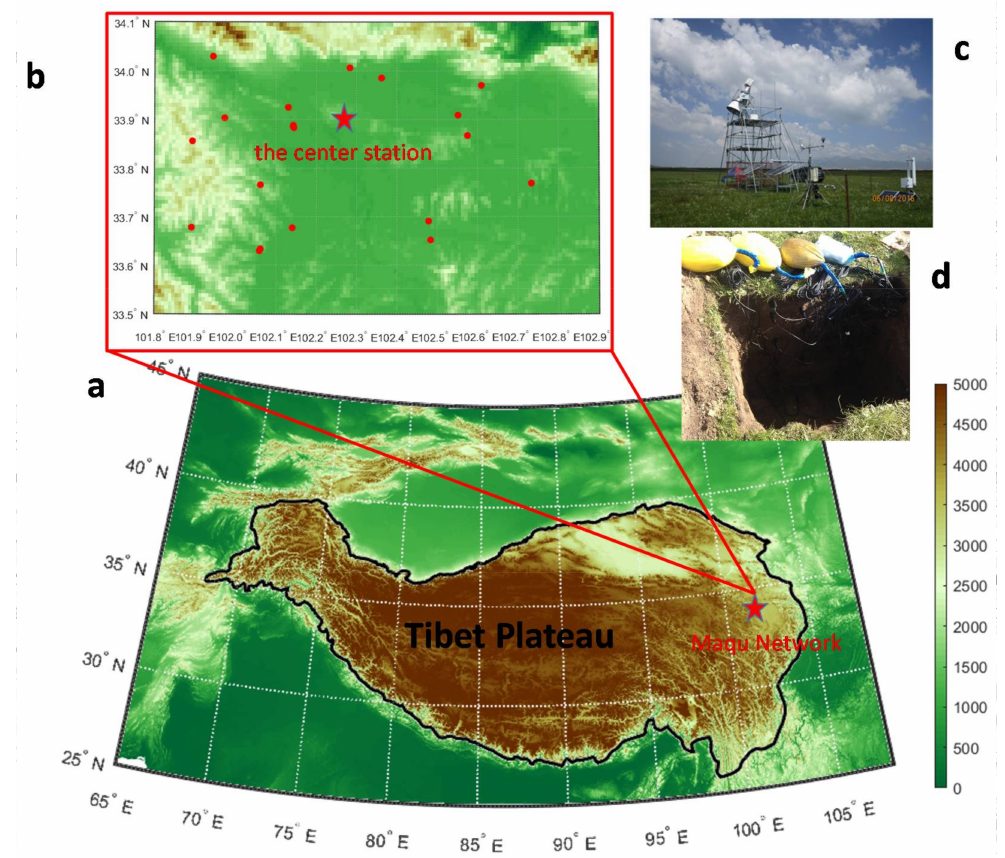
Figure 1. ( a ) Geographical location of the Maqu network on the Tibetan Plateau. The background indicates the elevation from USGS 1 km topography and the border in black is where elevation >2500 m; ( b ) The distribution of all sites at the Maqu network and the center site (ELBARA) located in the center; ( c ) ELABRA; ( d ) the detailed soil moisture and soil temperature